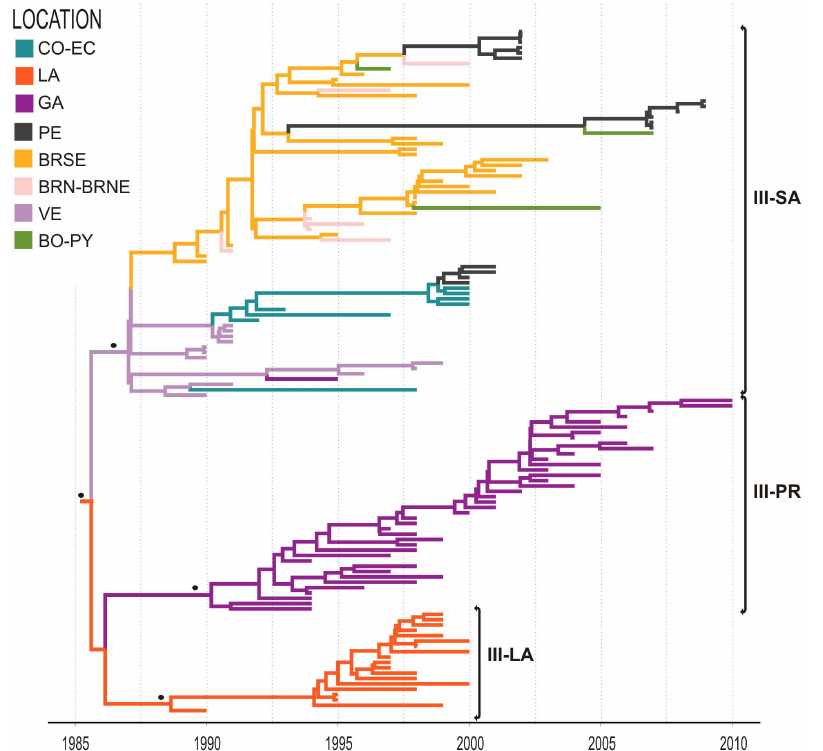
Figure 5. Time-scaled Bayesian Maximum Clade Credibility sub-tree corresponding to the Clade III. Three major highly supported monophyletic clades: III-PR, III-LA and III-SA are identified within clade III. For further details see legend of Fig 4. (CO-EC: Colombia-Ecuador, LA: Lesser Antilles, GA: Greater Antilles, PE: Peru, BRSE: Brazil Southeastern, BRN–BRNE: Brazil Northern-Brazil Northeastern, VE: Venezuela, BO-PY: Bolivia-